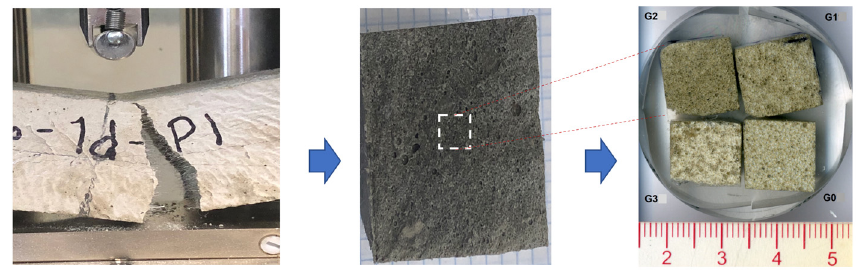
Figure 2. SEM samples embedded in resin and polished .